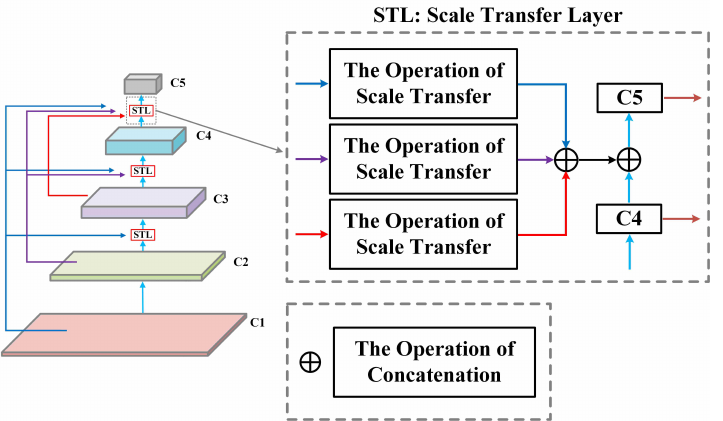
Figure 3. Structure of scale transfer layer, to realize the transition from low-level small-scale features to high-level large-scale